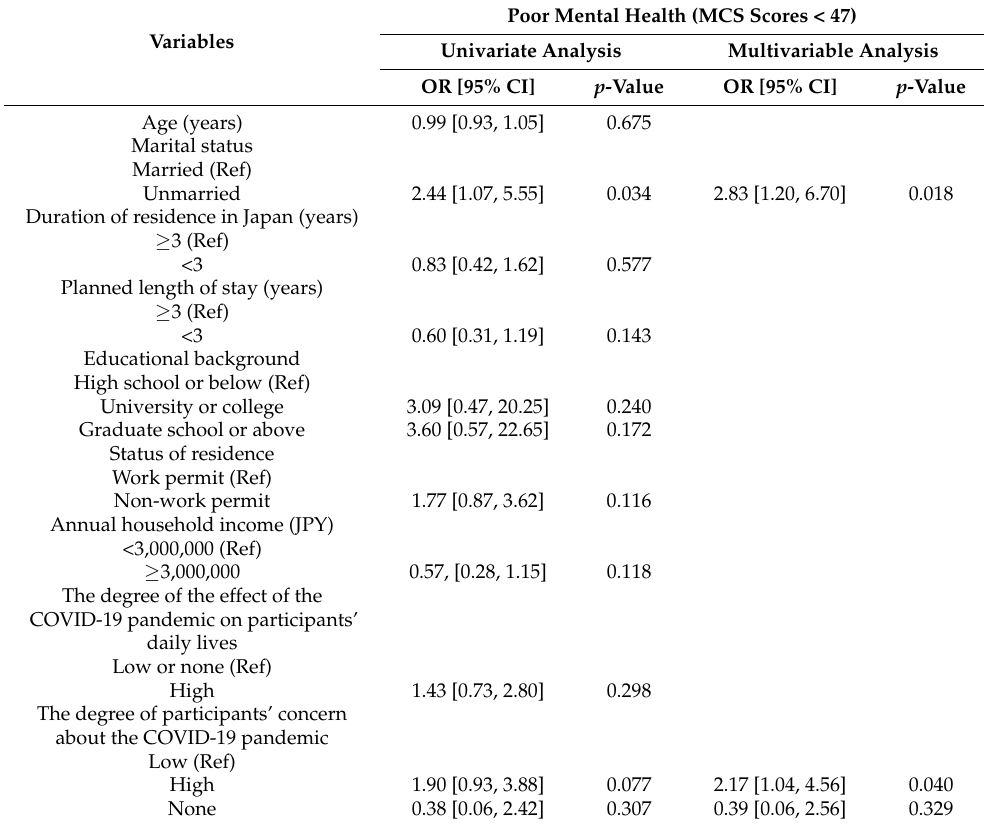
Table 4. Univariate analysis and multivariate logistic regression analysis of risk factors for poor mental health with MCS scores less than 47 (n =